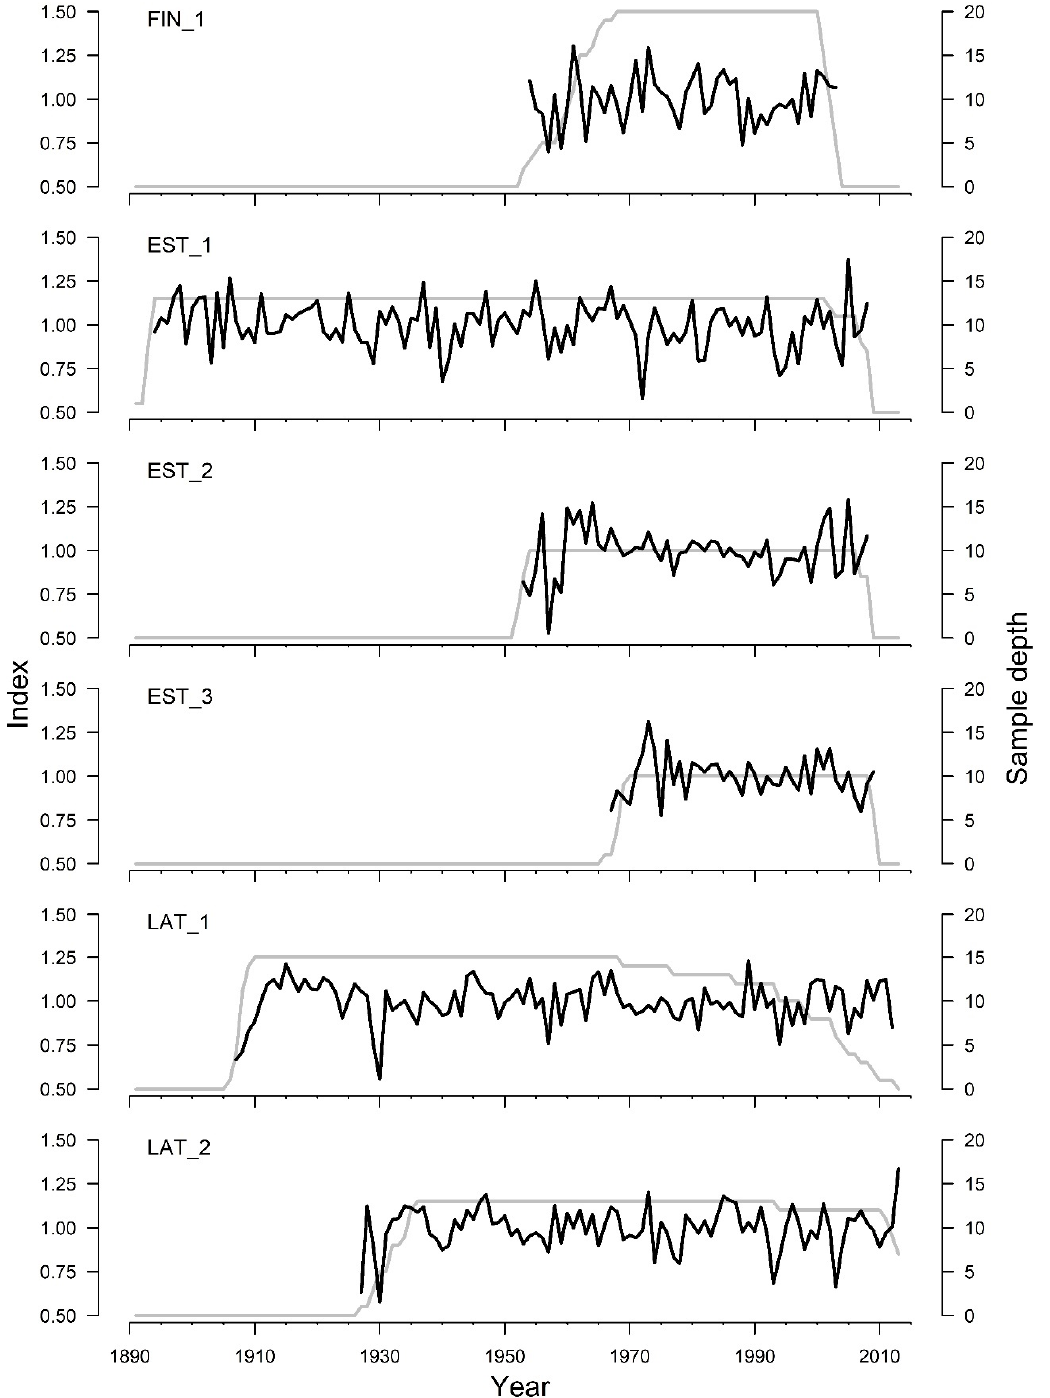
Figure 3. Residual chronologies (black line) of height increment of Scots pine from conventionally managed stands in Finland, Estonia and Latvia. Grey line indicates replication of annual data represented by the chronologies.